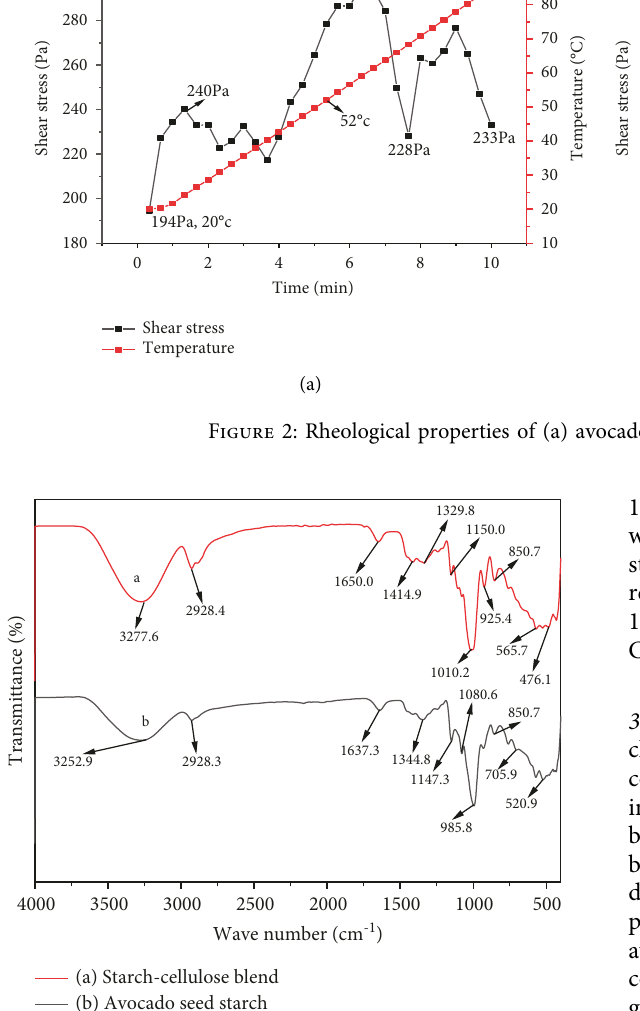
Figure 3. The avocado starch and the starch-cellulosic blend exhibited similar patterns in the 4000–400 cm − 1 region. The peaks below 800 cm − 1 exhibited the skeletal mode vibration of the glucose pyranose ring, whereas peaks in the range of 800 to 1500 cm − 1 reflect the characteristic vibration of glucose molecules. Avocado starch and the starch-cellulosic blend exhibited characteristic bands with peaks at 2928.3 cm − 1 and 2928.4 cm − 1 due to the symmetric stretching of C-H bonds. The band at 1637.3 cm − 1 and